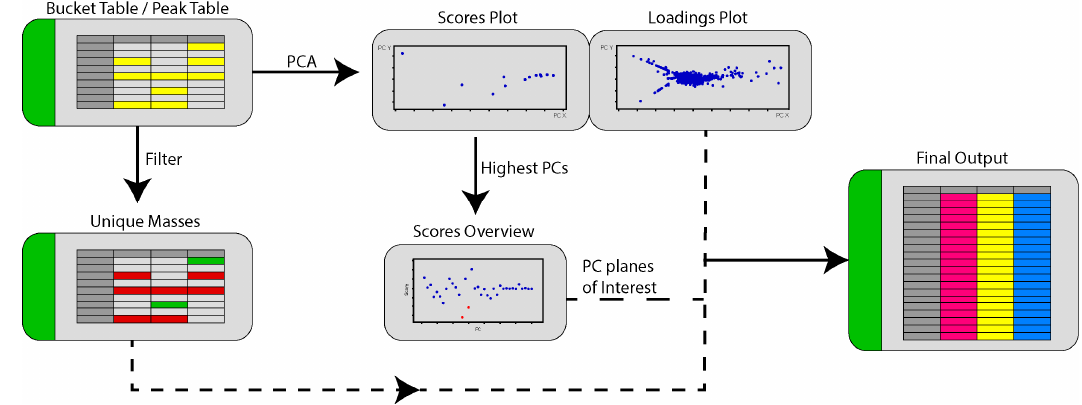
Figure 8. An overview of the process used by PoPCAR to generate a ranked list of unique features found for a particular strain in a PCA model. The final output is in Excel format and can be easily viewed.